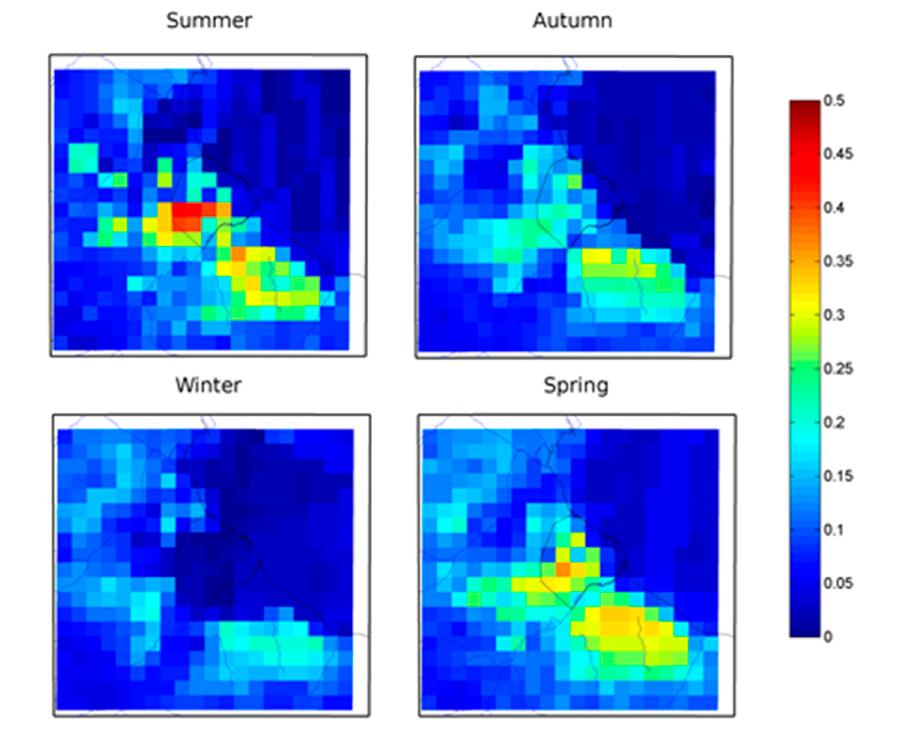
Figure 10. Aerosol optical depth seasonal average for 2014 from MODIS sensor (Aqua & Terra datasets combined) over Buenos Aires city and Gran Buenos